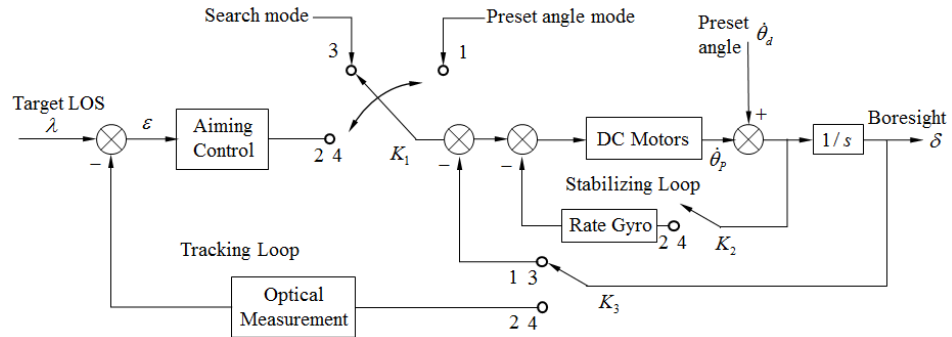
Figure 7. Diagram of the system operation modes.